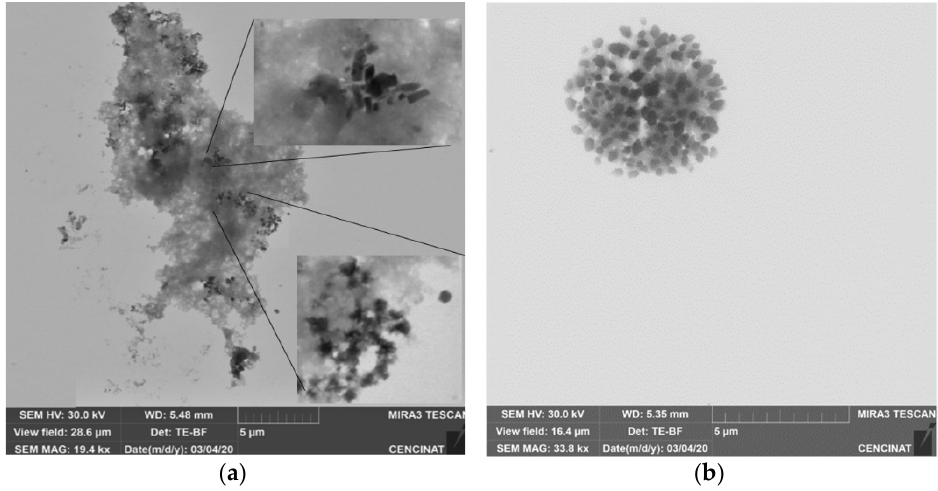
Figure 3. ( a ) FeO NPs agglomerated in the extract, and ( b ) FeO NPs agglomerated by adhesion between particles.